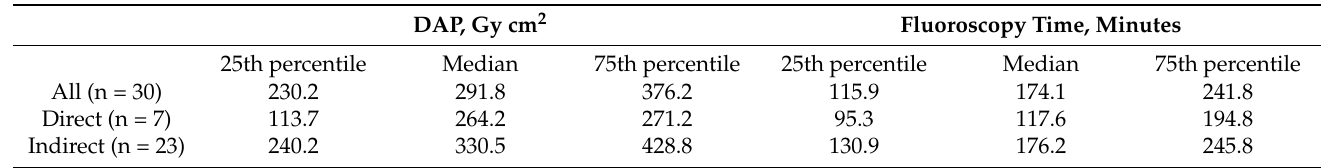
Table 2. Distribution of radiation dose and fluoroscopy time. DAP, Gy cm